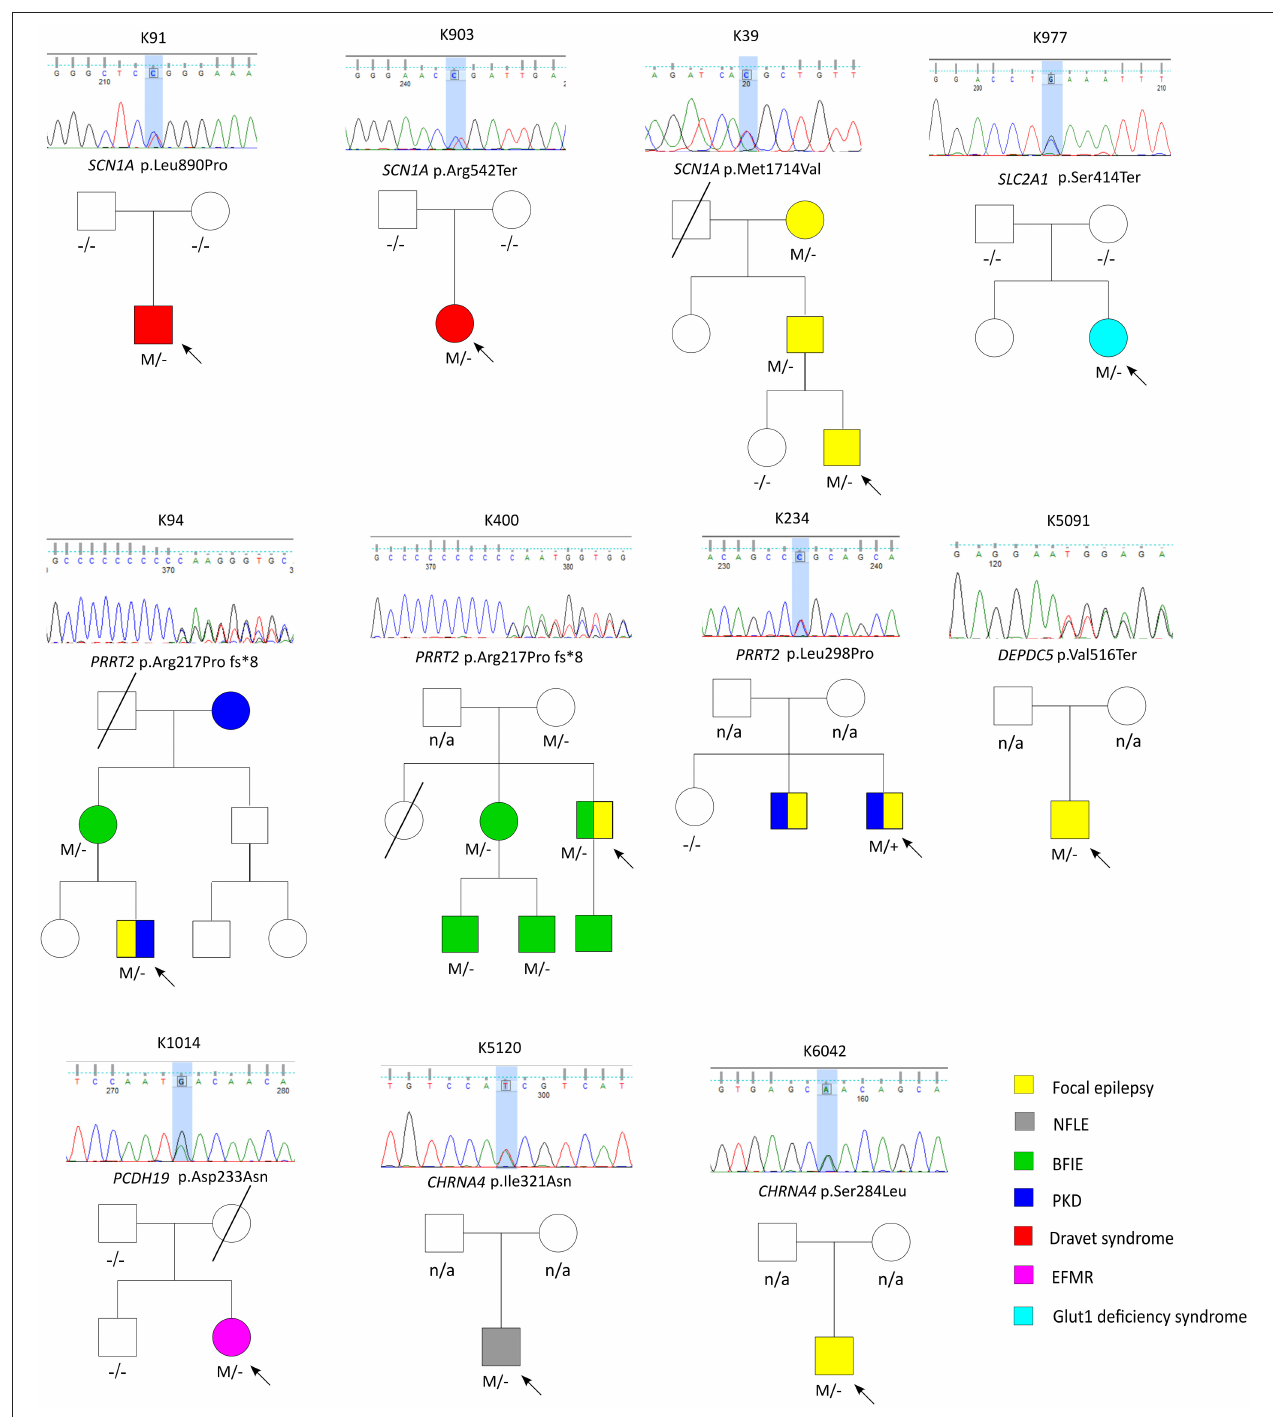
is predicted to be disease-causing by in silico programs. Both patients had nocturnal frontal lobe